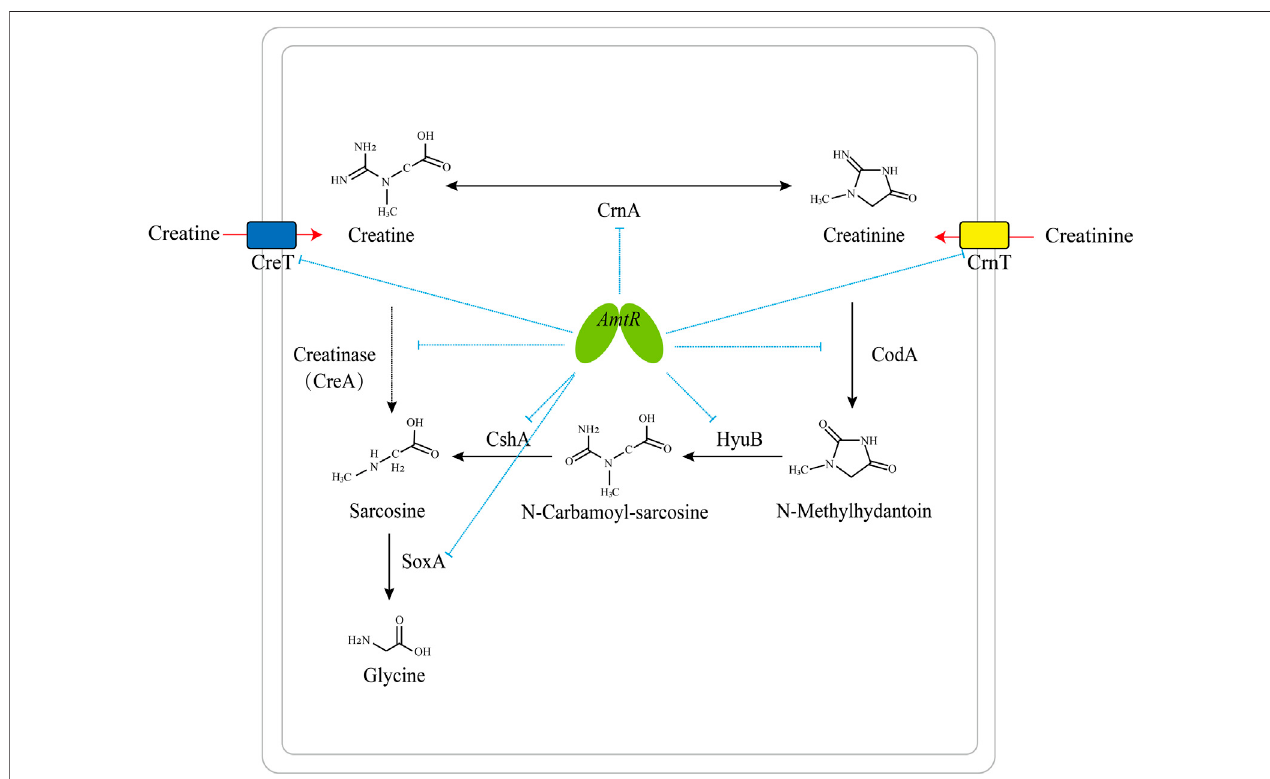
FIGURE7| Model oftheAmtRregulatingcreatine andcreatininedegradation in C.glutamicum ATCC 14067.Bluedotted line:transcriptional repression byAmtR; black arrows: creatine and creatinine degradation pathway; red arrows: the transport of creatine and creatinine; dotted arrow: creatinase (CreA) is not present in C. glutamicum ATCC